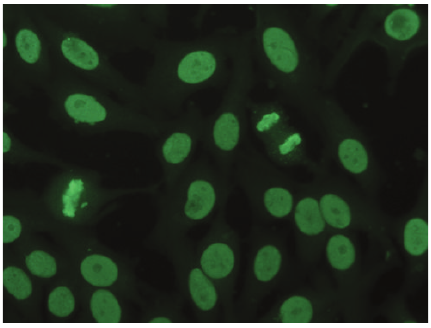
Figure 1: IIF on Hep2 cells: homogeneous pattern. Dilution 1 :40.